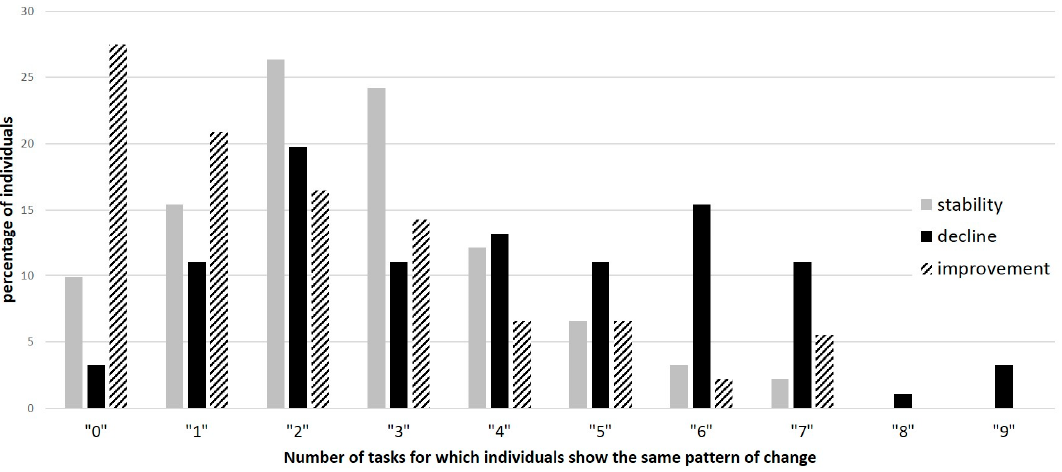
Figure 4. Heterogeneity in the pattern of change across all conditions: decline (black bars), improvement (dashed bars) and stability (grey bars). For example, 27% never presented a significant improvement, and 16% of individuals showed decline in six conditions.